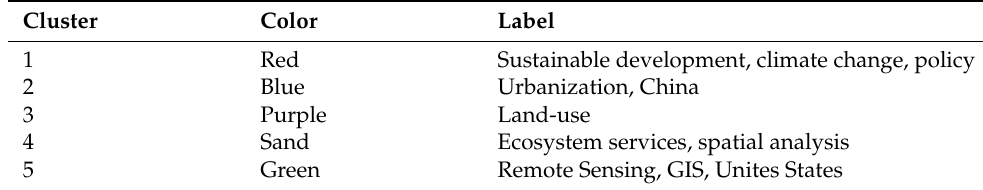
Figure 9. VOSviewer results of co-occurrences in papers published in Sustainability 2009–2021 with key terms “remote AND sensing”: see Appendix A.2 for details. Table 3. Interpretation of co-occurrence clusters displayed in Figure 9.